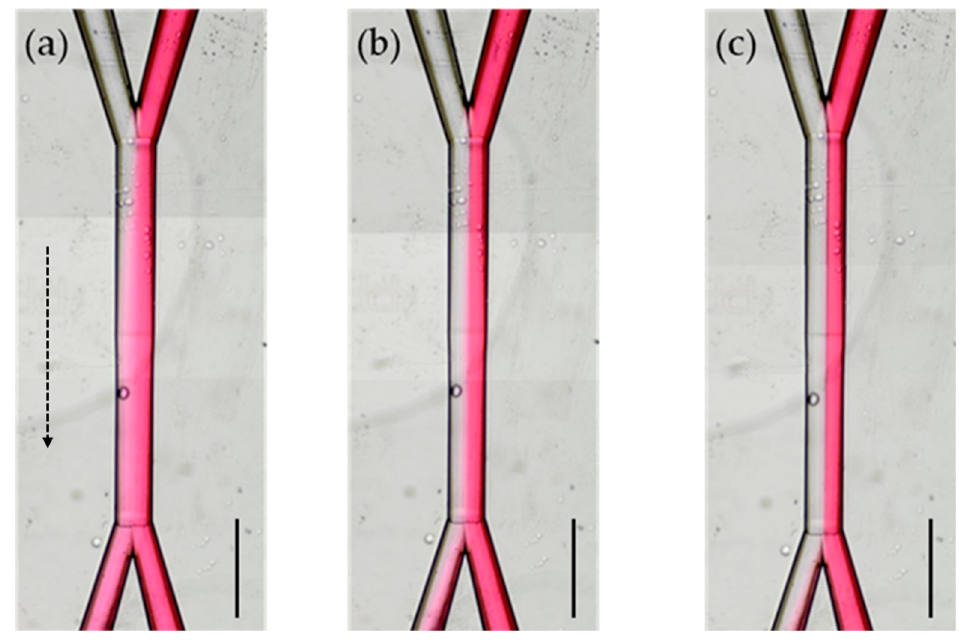
Figure 4. Diffusion behavior inside a microfluidic chip with 30° incident angle and h = 500 μ m, at increasing pumping pressure ( a ) Δ P = 25 mbar; ( b ) Δ P = 75 mbar; ( c ) Δ P = 200 mbar. Scale bars correspond to 500 μ m. Arrow indicates the flow direction.